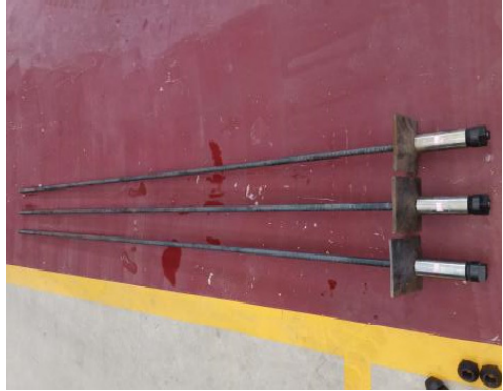
Figure 3. Energy absorbing anchor.